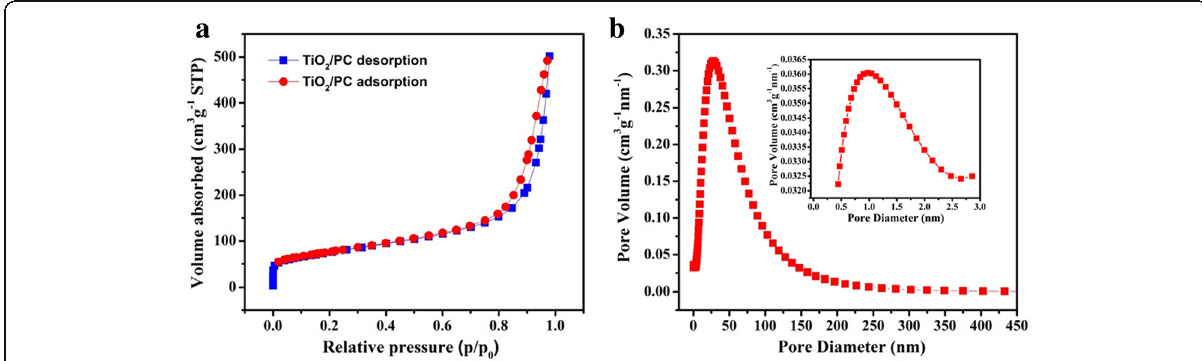
Fig. 4 a N 2 adsorption – desorption isotherms. b Pore diameter distribution of TiO 2 /PC. Inset: magnification of pore diameter distribution between 0 and 3